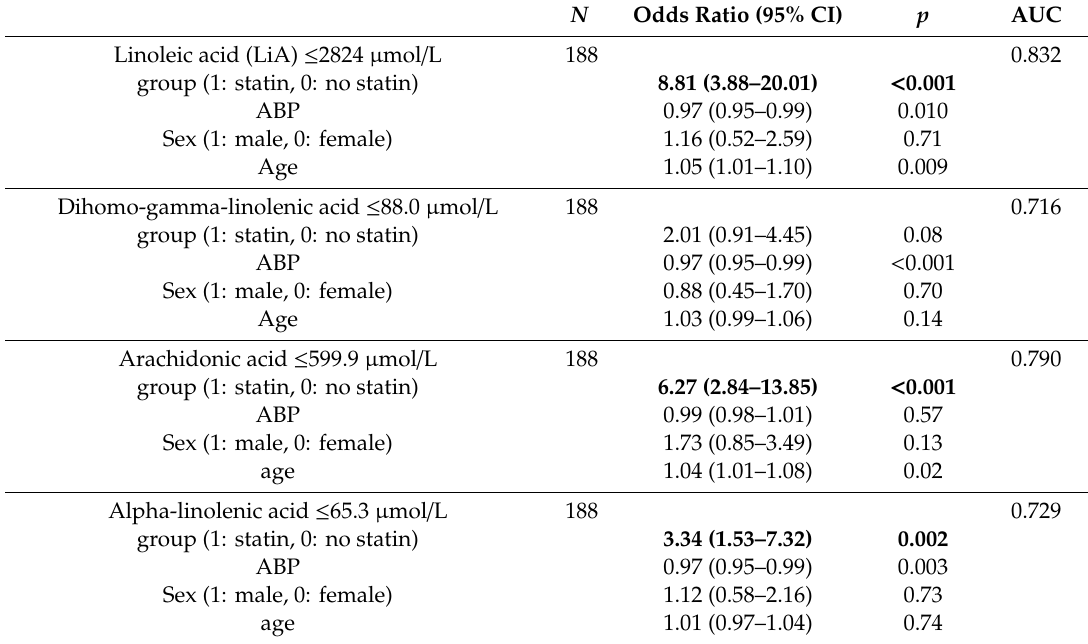
Table 5. Multiple logistic regression analysis for low levels of n-6 PUFAs and n-3 PUFAs and FA wt % adjusted to age, sex. ABP, and